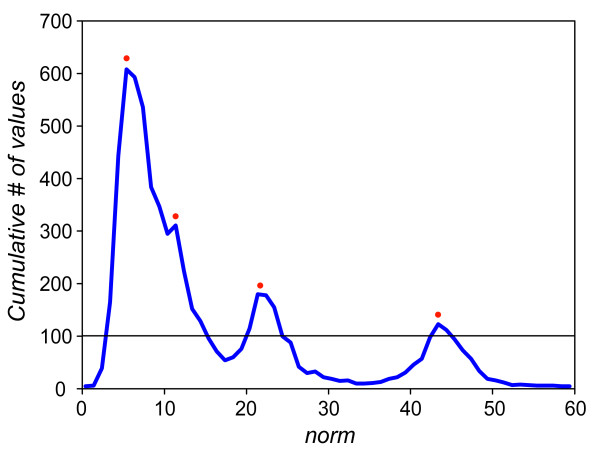
Distribution ofℓ1-norm values of input singular vectors.